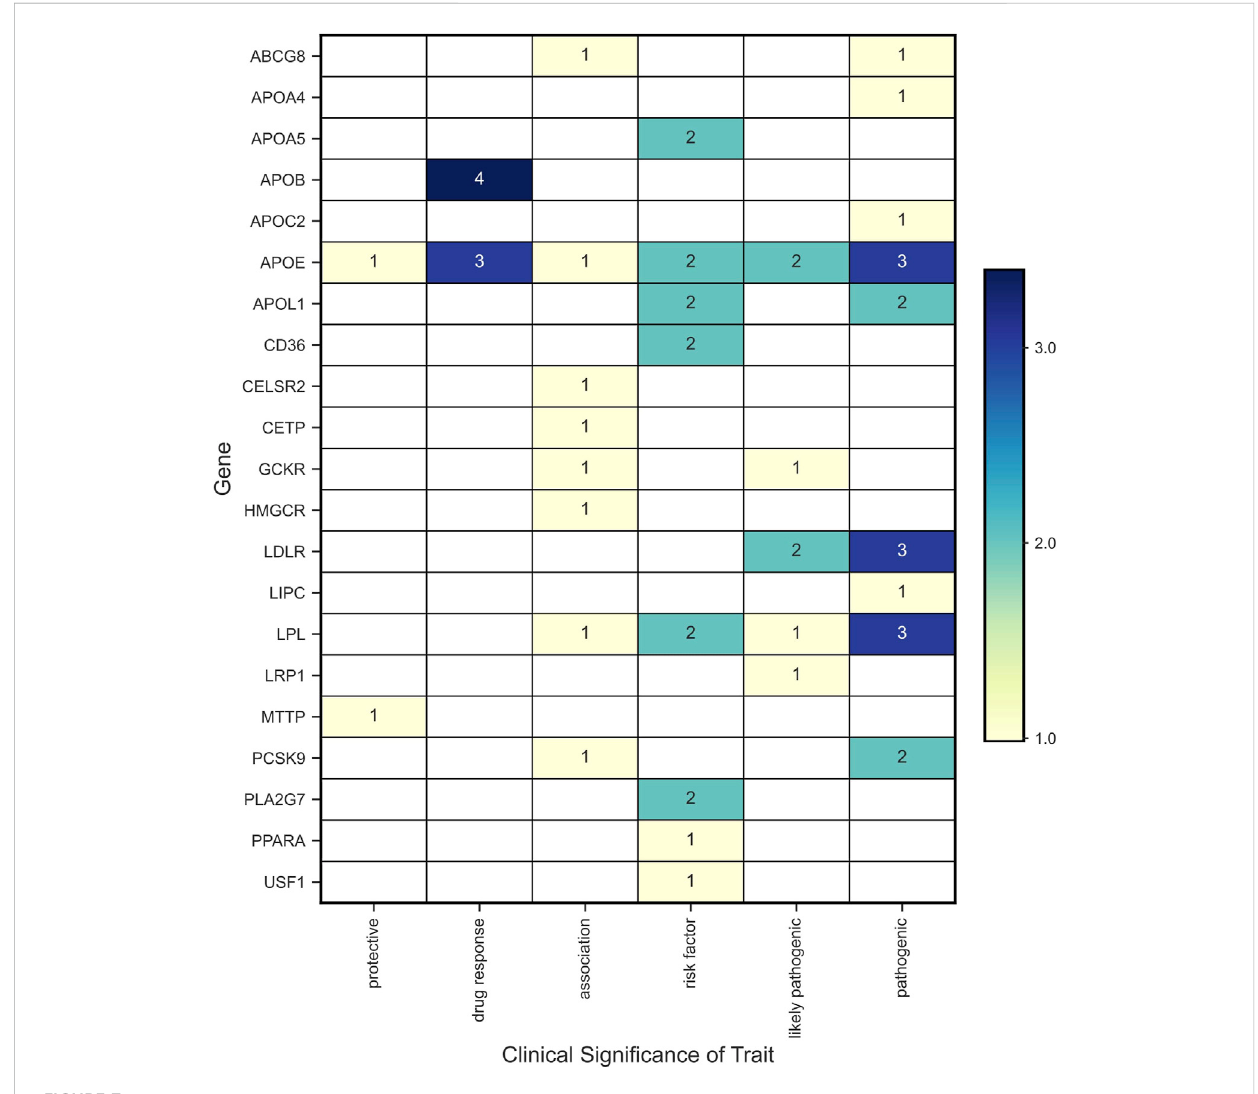
FIGURE 7 Variants with clinical signi fi cance according to the phenotypic associations reported in